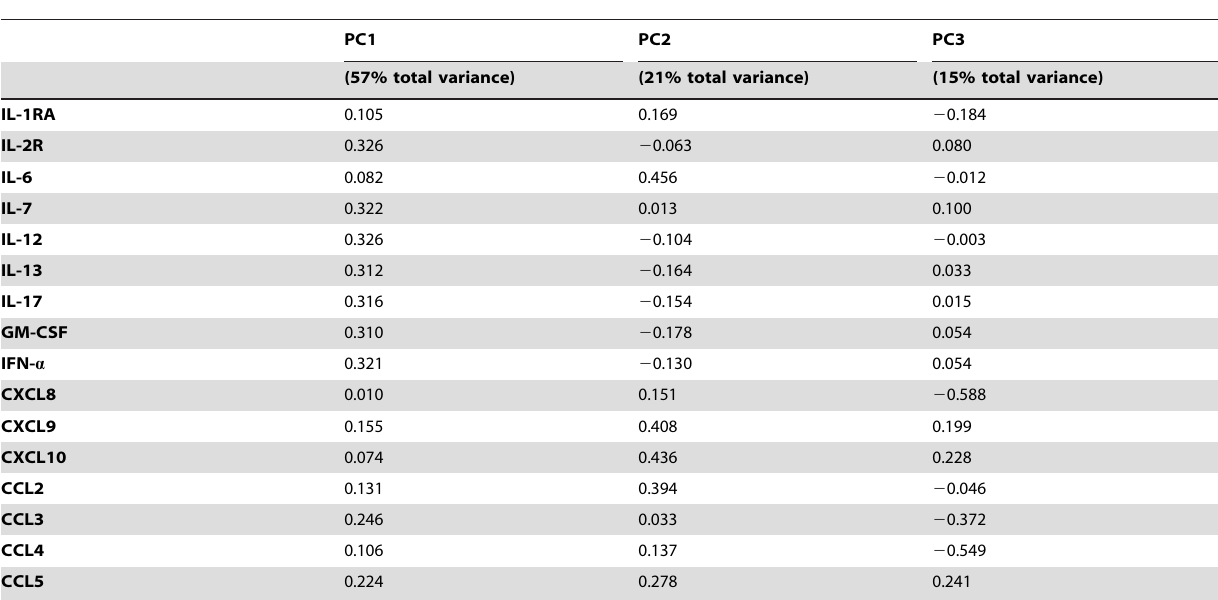
Table 4. Principal component analysis of pre dexamethasone sputum supernatant